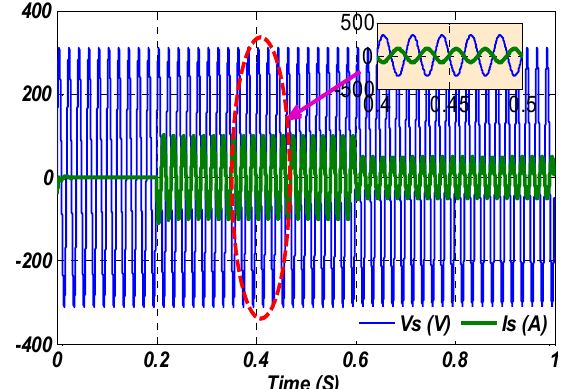
Figure 19. Stator three-phase currents (A).